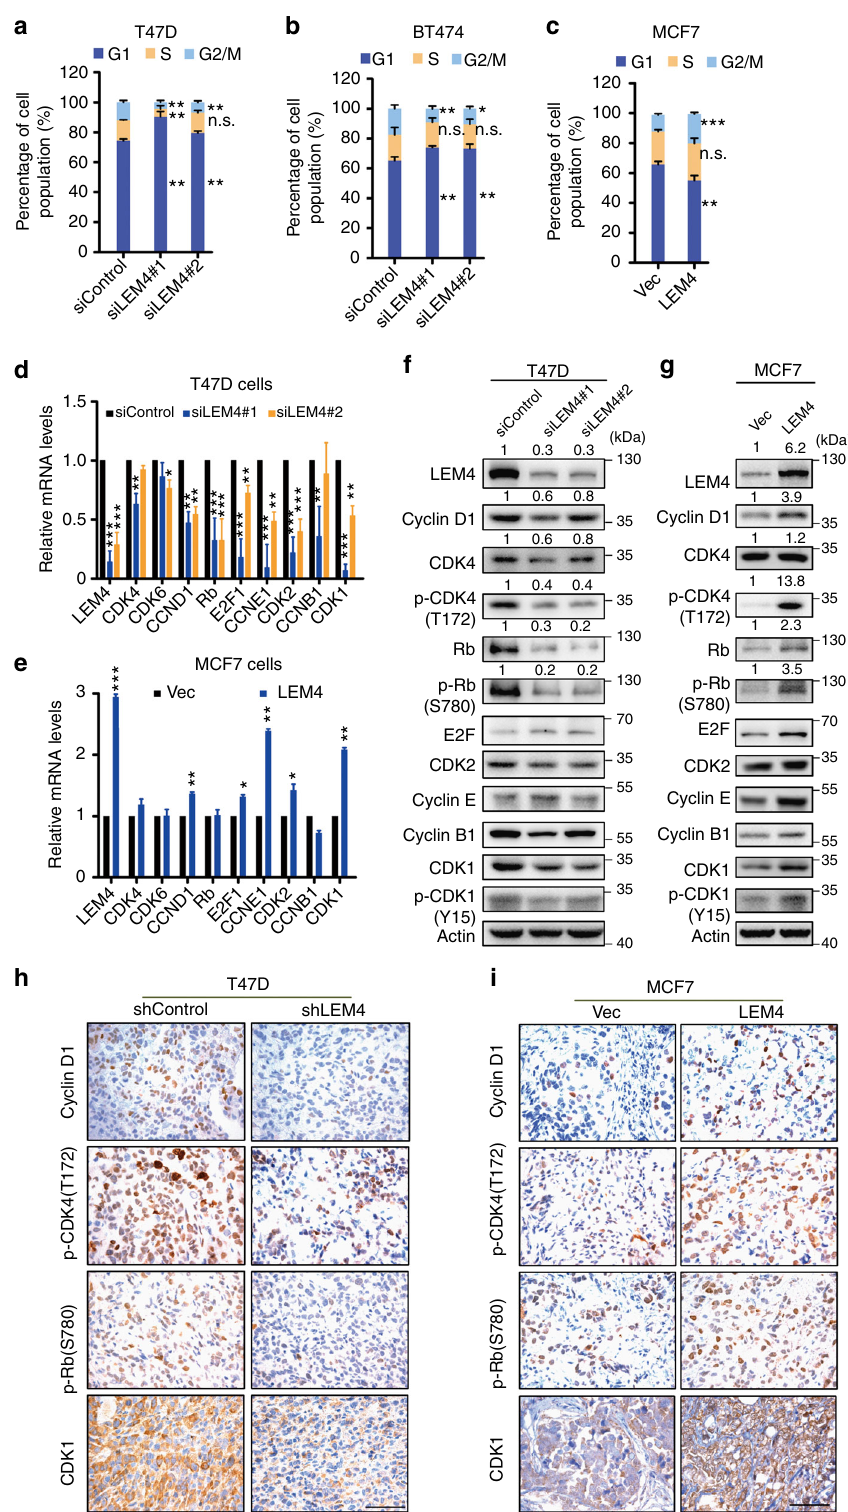
Fig. 3 LEM4 overexpression promotes the G1 to S phase transition. a – c Depletion of LEM4 in T47D ( a ) and BT474 ( b ) cells and overexpression of LEM4 in MCF7 cells ( c ) altered the proportion of cells in G1, S, and G2/M phase by FACS analysis. d , e Real-time RT-PCR analysis of the cell cycle-related gene expression in T47D cells with LEM4-depleted ( d ) and LEM4-overexpressing MCF7 cells ( e ). f , g Immunoblot of cell cycle-related gene expression using the indicated antibodies in LEM4-depleted T47D cells ( f ) and MCF7-LEM4 cells ( g ). h , i Immunohistochemical analysis of the expression of cyclin D1, p-CDK4 (T172), p-Rb (S780), and CDK1 in tumors (Fig. 2f, g). Sizes of cell populations averaged from three independent experiments with standard deviations. Scale bars, 50 μ m. * P < 0.05, ** P < 0.01, *** P < 0.001. Tukey ’ s multiple comparisons test for a , b , d , e . Student ’ s t-test for